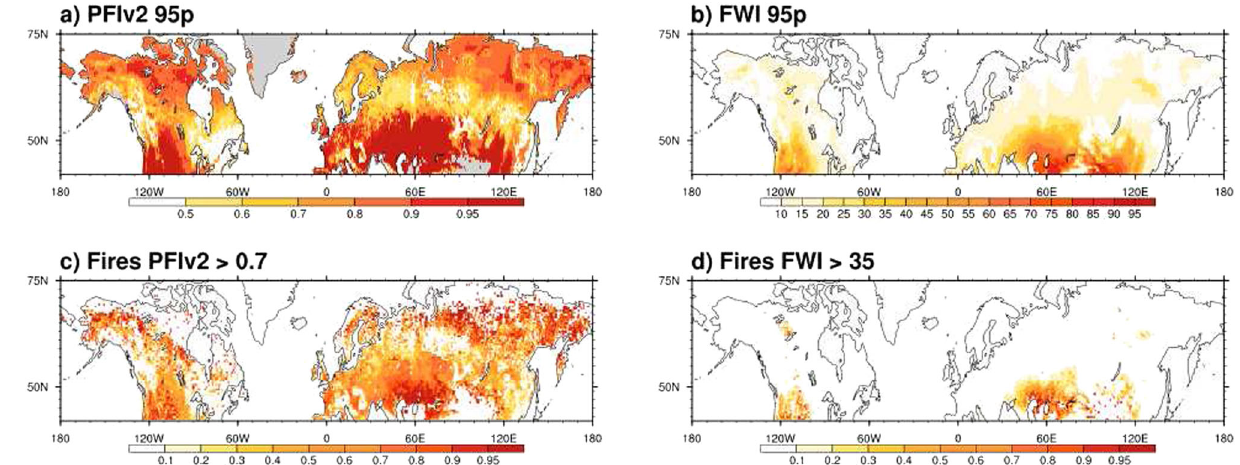
Fig. 2 Extreme fi re danger and observed fi res. 95th percentile based on daily values of PFIv2 ( a ) and ( b ) for the FWI based on 2001 – 2016 interval. a , b Are shown in different scales. c and d show the ratio of satellite-detected fi res with respect to the total accumulated in 2001 – 2016 for PFIv2 > 0.7 and FWI > 35 (high danger